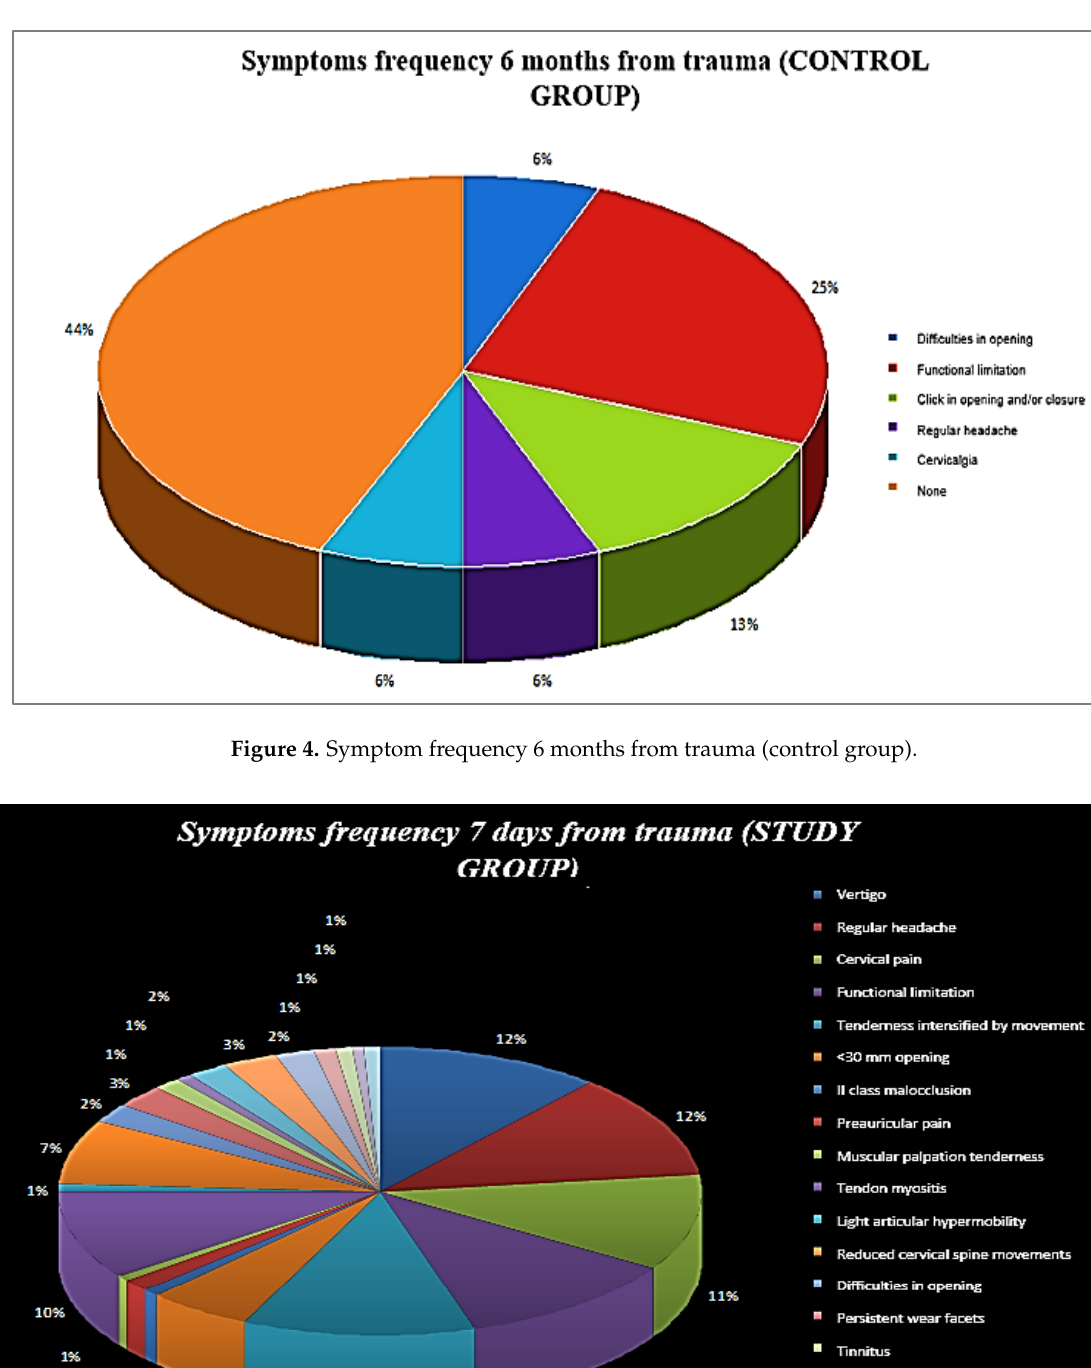
Figure 6. Symptom frequency 6 months from trauma (study group).